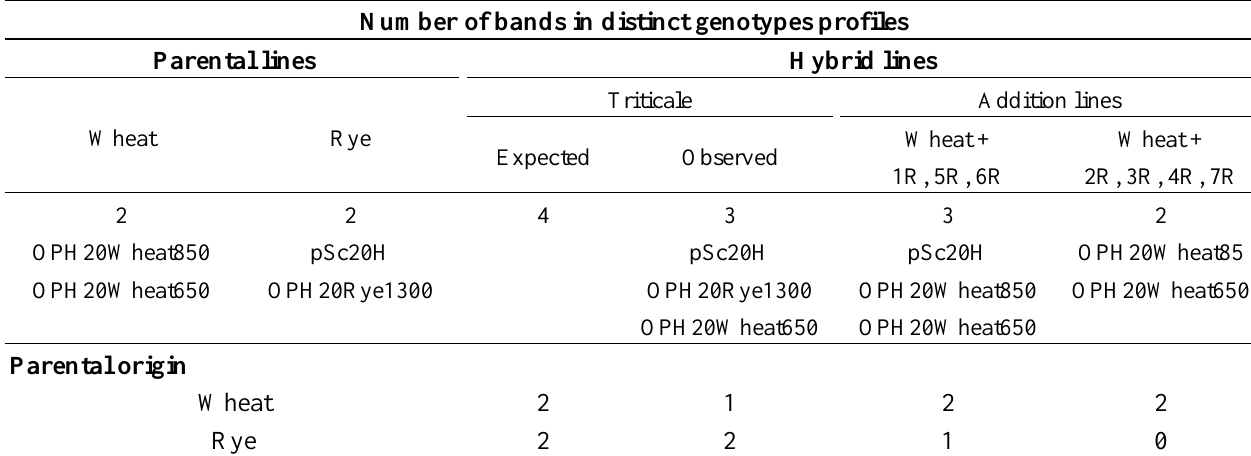
Table 1. Characterization of PCR banding profiles obtained with OPH20 10-mer primer in wheat, rye, triticale and wheat lines with the addition of rye chromosomes. Number of bands in distinct genotypes profiles Parental lines Hybrid